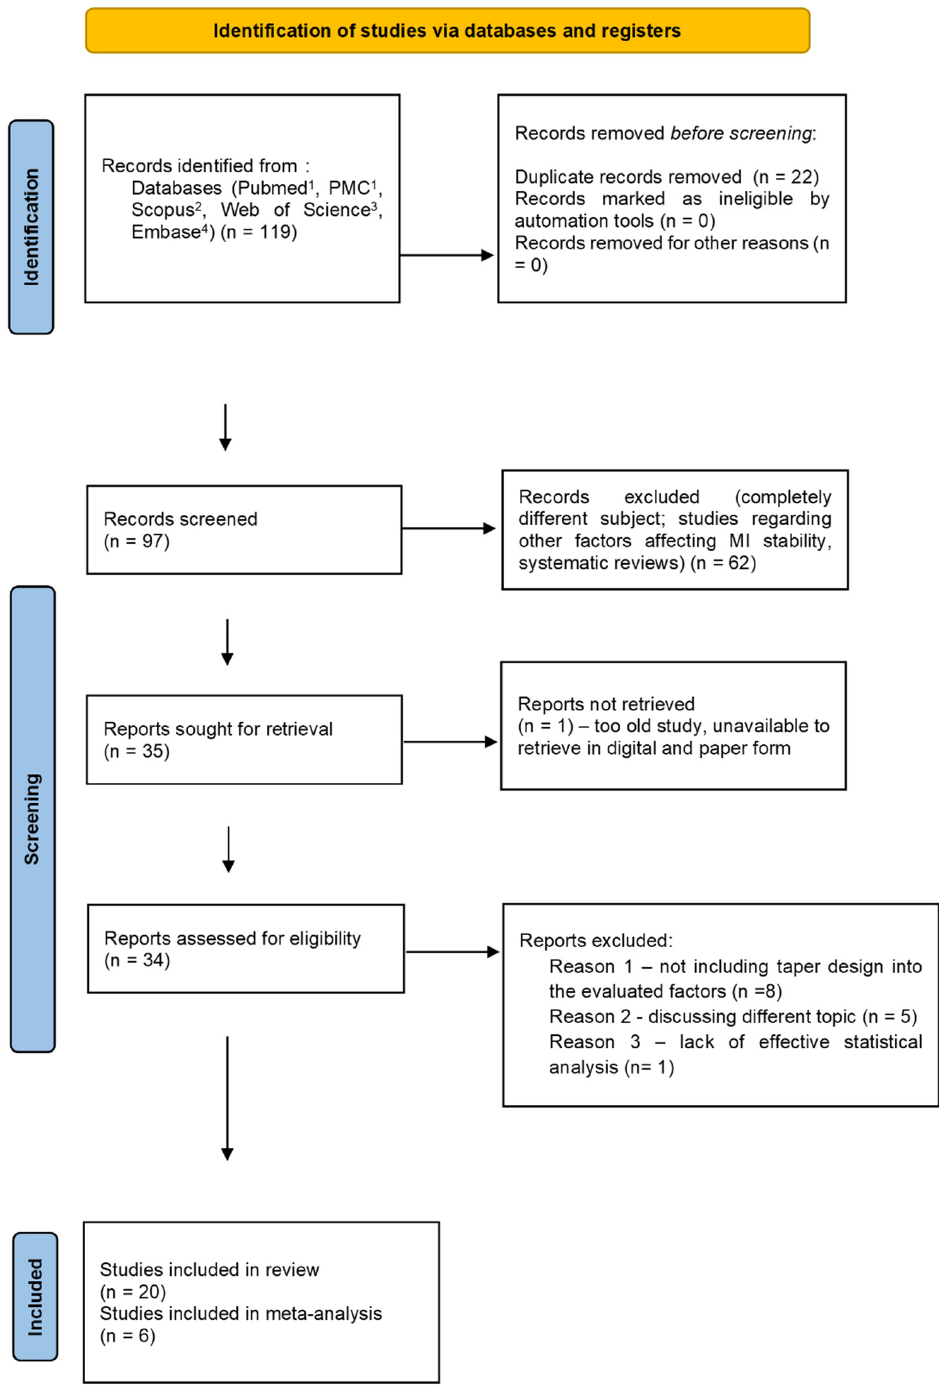
Figure 1. Prisma 2020 flow diagram. 1 —search string: (“mini-implant” OR “miniscrew” OR “TAD” OR “temporary anchorage device” OR “skeletal anchorage”) AND (“orthodontics”[MeSH Terms] OR “malocclusion”[MeSH Terms] OR “Tooth Movement Techniques”[MeSH Major Topic]) AND (“thread” OR “thread pitch” OR “thread depth” OR ”thread shape” OR “thread design”)AND (“success rate” OR “success” OR “successful” OR “survival rate” OR “failure risk” OR “treatment success” OR “stability”)—20 + 45 results; 2 —search string: TITLE-ABS-KEY ((“mini-implant” OR “miniscrew” OR “TAD” OR “temporary anchorage device” OR “skeletal anchorage”) AND (“or- thodontics” OR “malocclusion” OR “Tooth Movement Techniques”) AND (“thread” OR “thread pitch” OR “thread depth” OR “thread shape” OR “thread design”) AND (“success rate” OR “suc- cess” OR “successful” OR “survival rate” OR “failure risk” OR “treatment success” OR “stabil- ity”))—24 results; 3 —search string: Results for (“mini-implant” OR “miniscrew” OR “TAD” OR “temporary anchorage device” OR “skeletal anchorage”) AND (“orthodontics” OR “malocclusion” OR “Tooth Movement Techniques”) AND (“thread” OR “thread pitch” OR “thread depth” OR “thread shape” OR “thread design”) AND (“success rate” OR “success” OR “successful” OR